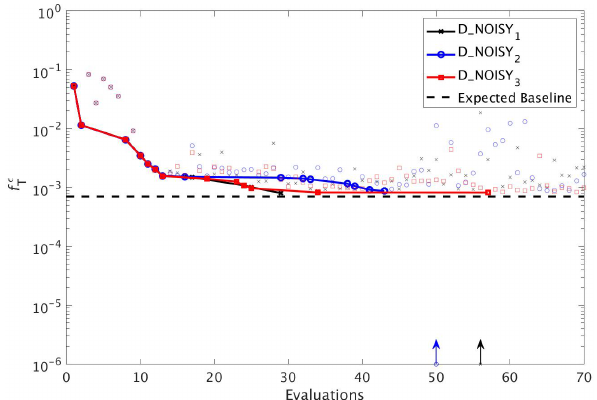
Figure 10. As in Fig. 8, but for experiments D_NOISY 1 (black line with crosses), D_NOISY 2 (blue line with circles) and D_NOISY 3 (red line with squares). Vertical arrows indicate a soft restart, coloured and marked according to each